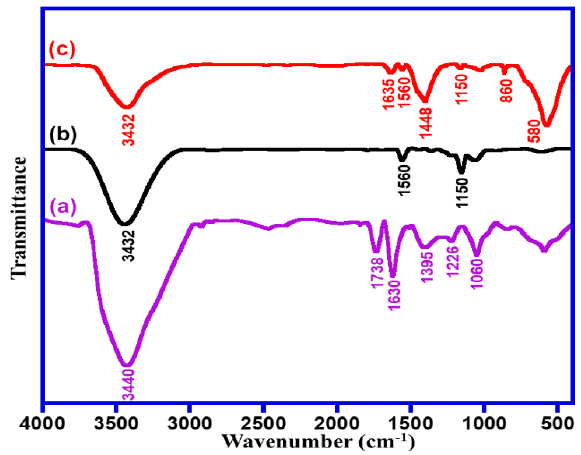
Figure 3. FTIR analysis of ( a ) GRO, ( b ) NDG, and ( c ) (1%)NDG/MnCO 3 –(1%)ZrO 2 samples.